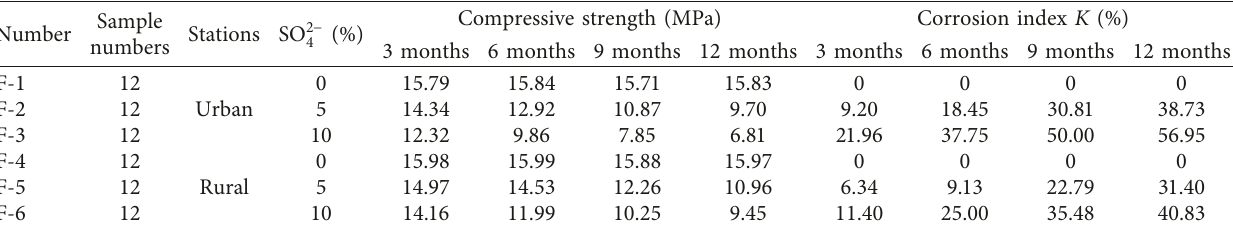
Table 4: The corrosion test results of concrete at urban and rural observation stations.